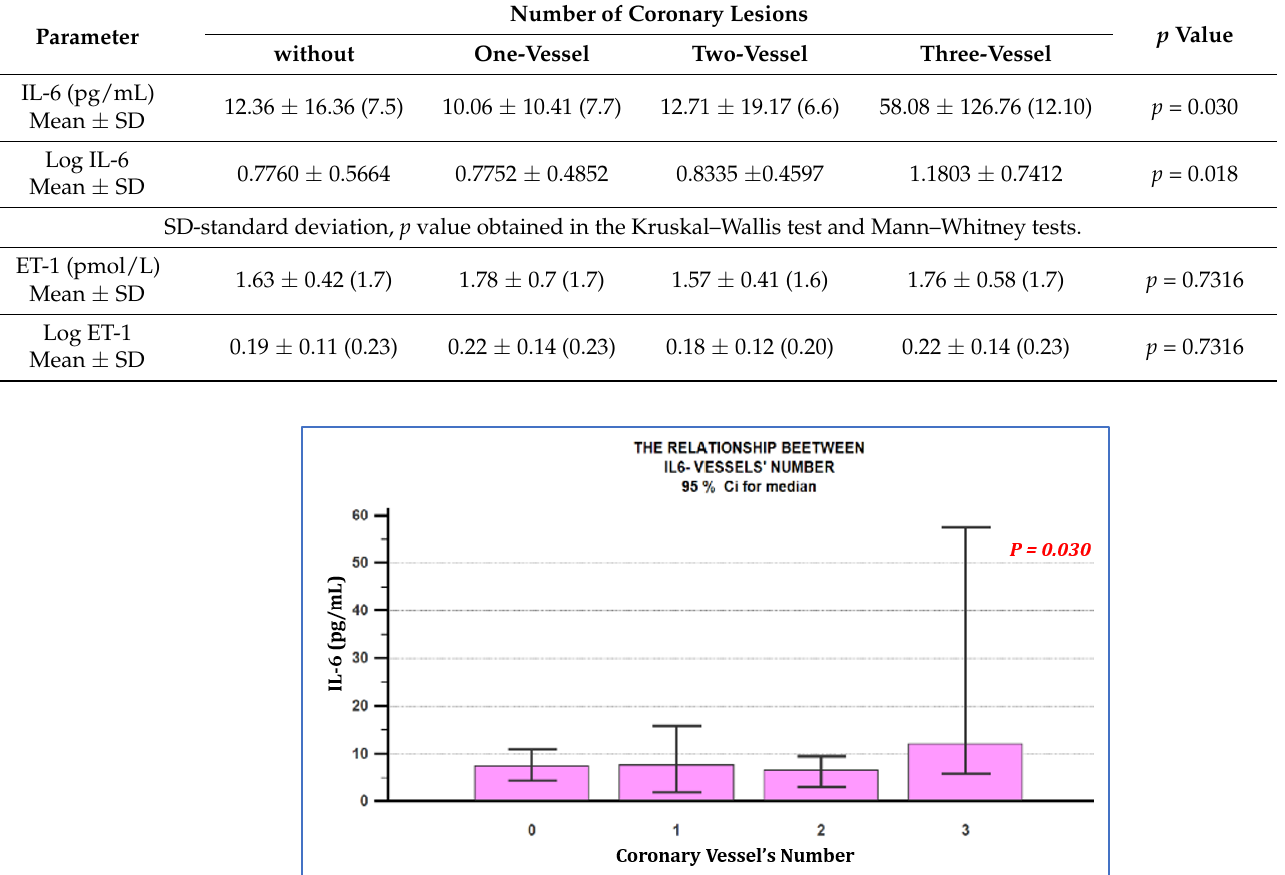
Figure 2. The relationship between plasma ET-1 concentration and the number of coronary lesions. The plasma concentration of ET-1 did not show significant differences either in terms of the type of